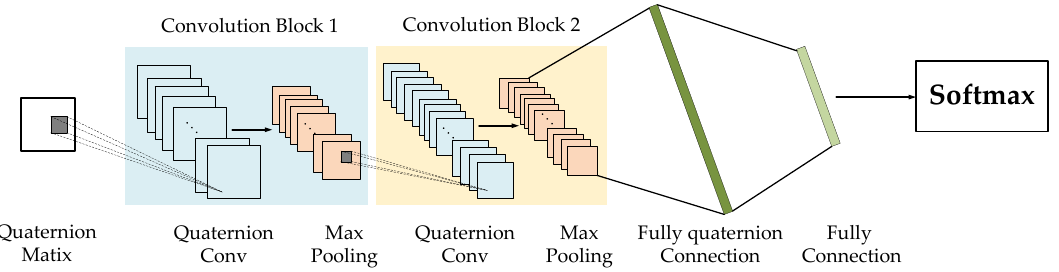
Figure 2. The framework of the